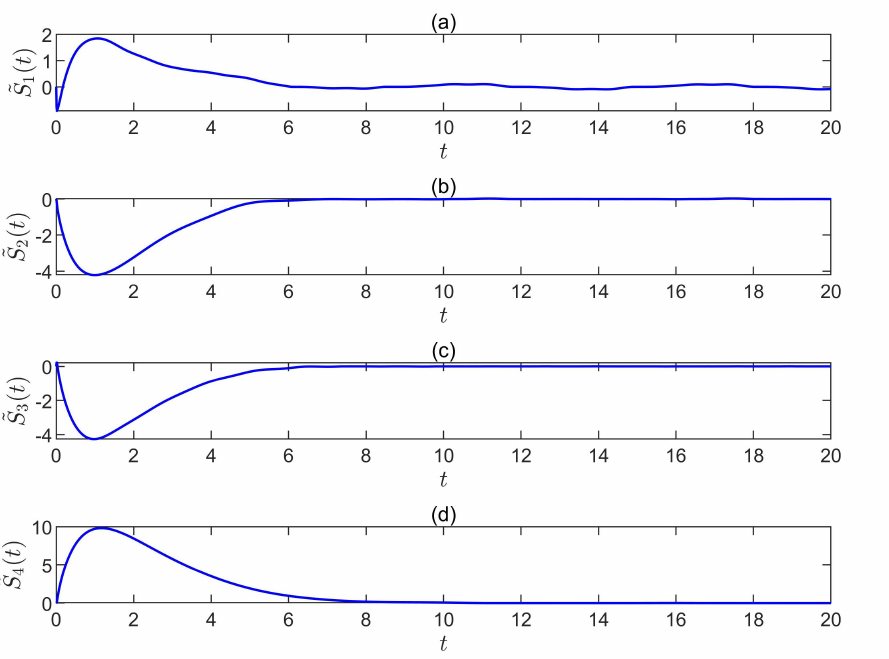
Figure 7. The sliding-mode surface of the system: ( a ) the ˜ S 1 − t space; ( b ) the ˜ S 2 − t space; ( c ) the ˜ S − t space; ( d ) the ˜ S − t 3 4